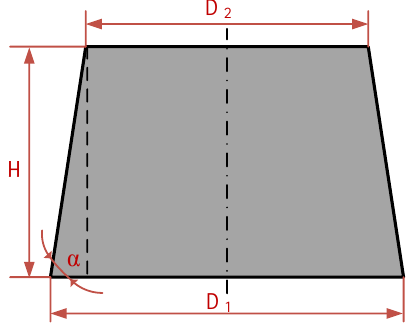
Figure 3. Diagrammatic drawing of the micropillar bottom angle.